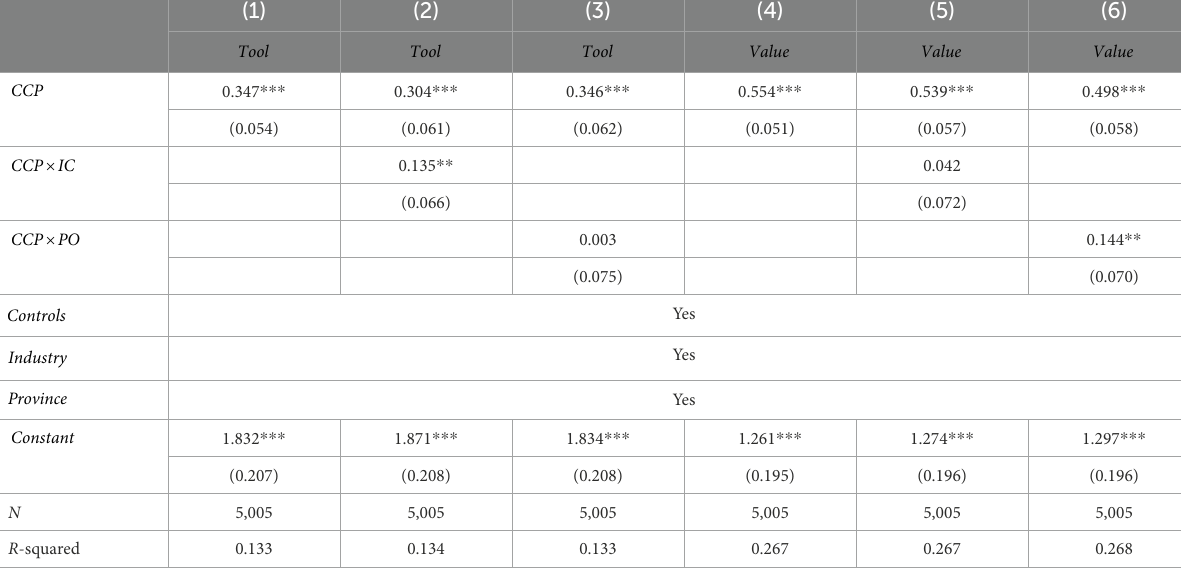
TABLE 6 Party branches and CSR in Chinese private enterprises: moderating effects of political